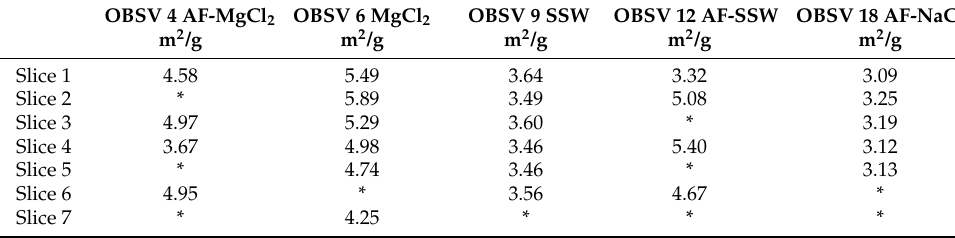
Table 4. Measured SSA for flooded unfractured and artificially fractured samples. For the fractured cores (OBSV 4 AF-MgCl 2 , OBSV 12 AF-SSW, and OBSV 18 AF-NaCl), the material is extracted from the peripheral parts of the cores, not in touch with the fracture. * Data not